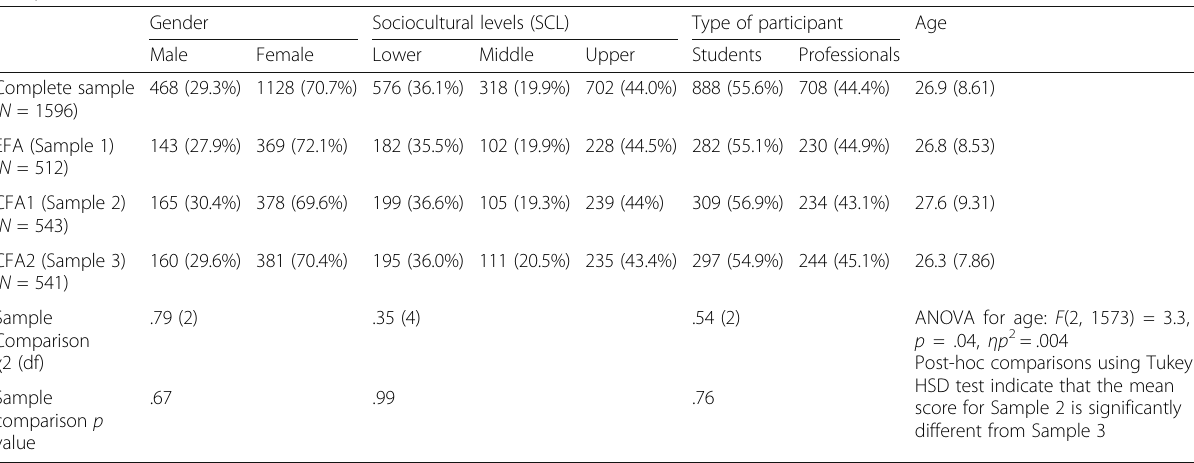
Table 1 Demographic characteristics by sample (gender, sociocultural levels, students vs. professional, and age) and